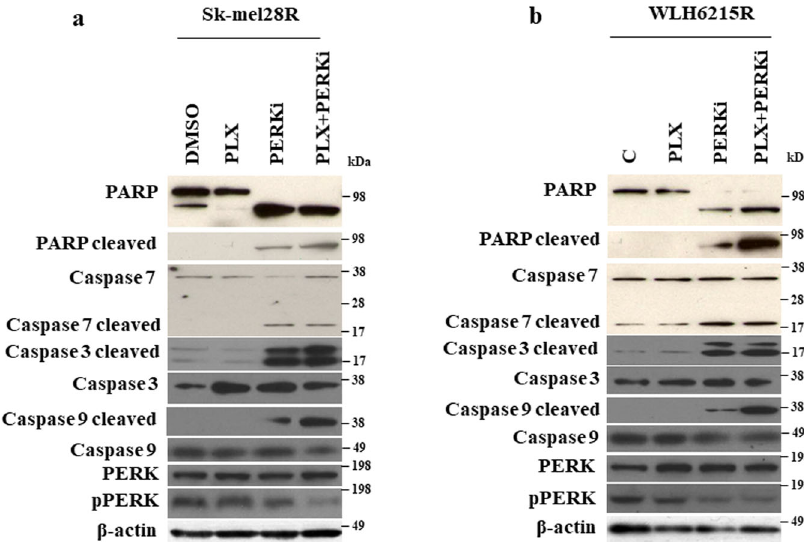
Fig. 5 Inhibition of PERK by a small molecular inhibitor induced tumor cell apoptosis. a , b Western blot showed the indicated protein levels in human BRAFi-resistant melanoma Sk-mel28R ( a ) and WLH6215R ( b ) treated with 5 μ M of BRAFi PLX4032 or 5 nM of PERK inhibitor GSK2606414 and combination of BRAFi and PERKi for 48 h. DMSO, as control; PLX, BRAF inhibitor PLX4032; PERKi, PERK inhibitor GSK2606414; PLX + PERKi, the combination of BRAFi PLX and PERKi GSK2606414. The protein of β -actin as a loading